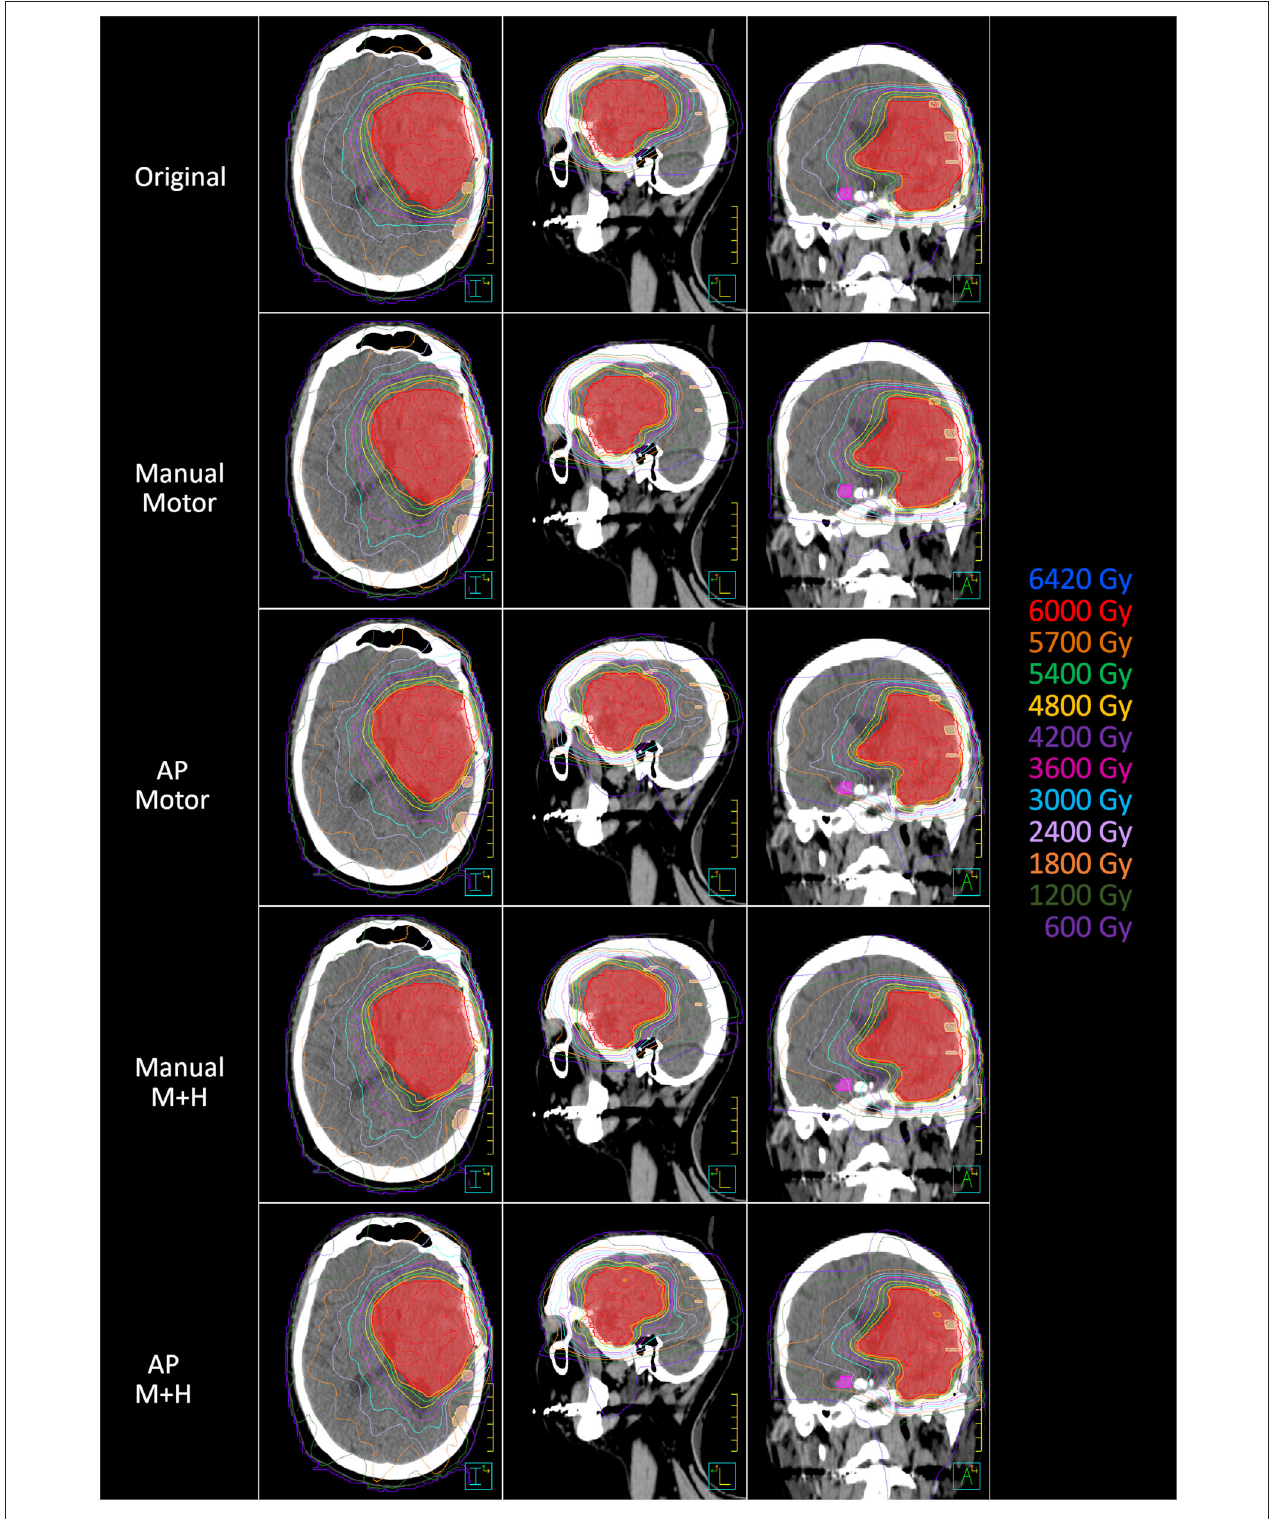
FIGURE 2 | Example of the dose distribution in the planning CT (axial, sagittal, and coronal axis) (left, middle, and right). PTV = red color, motor cortex = skin color, contralateral hippocampus = pink color.